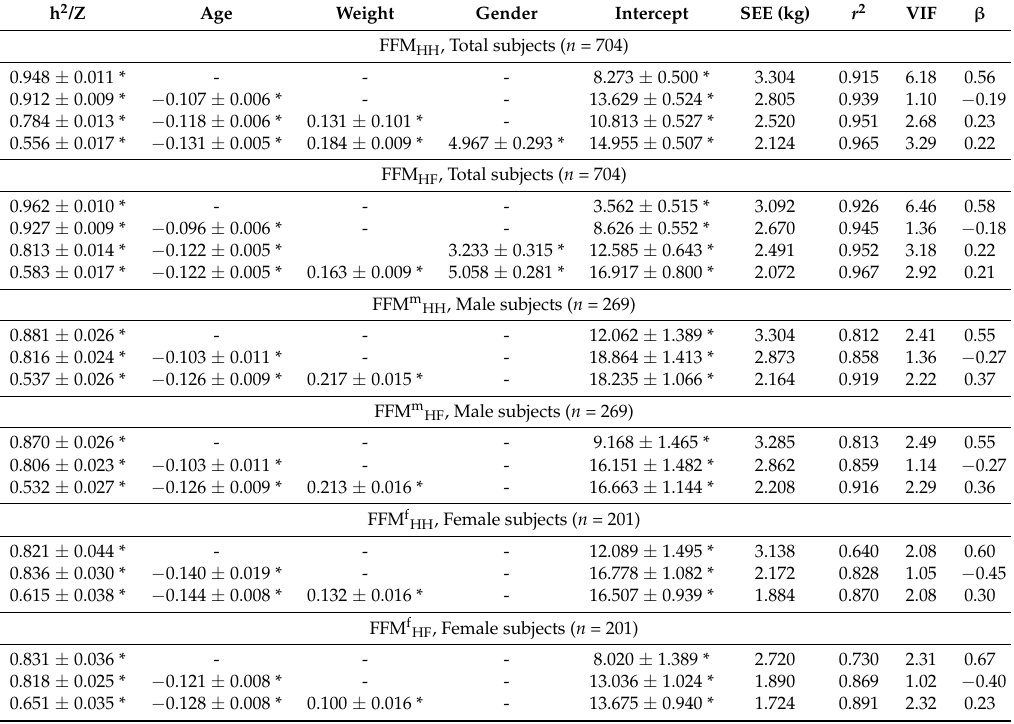
FFM DXA , DXA ‐ measured fat free mass; Regression coefficient estimate ± SEE; r 2 , coefficient of determination; * p < 0.001; β , standardized coefficient; VIF, variance inflation factor; SEE, standard error of the estimate.